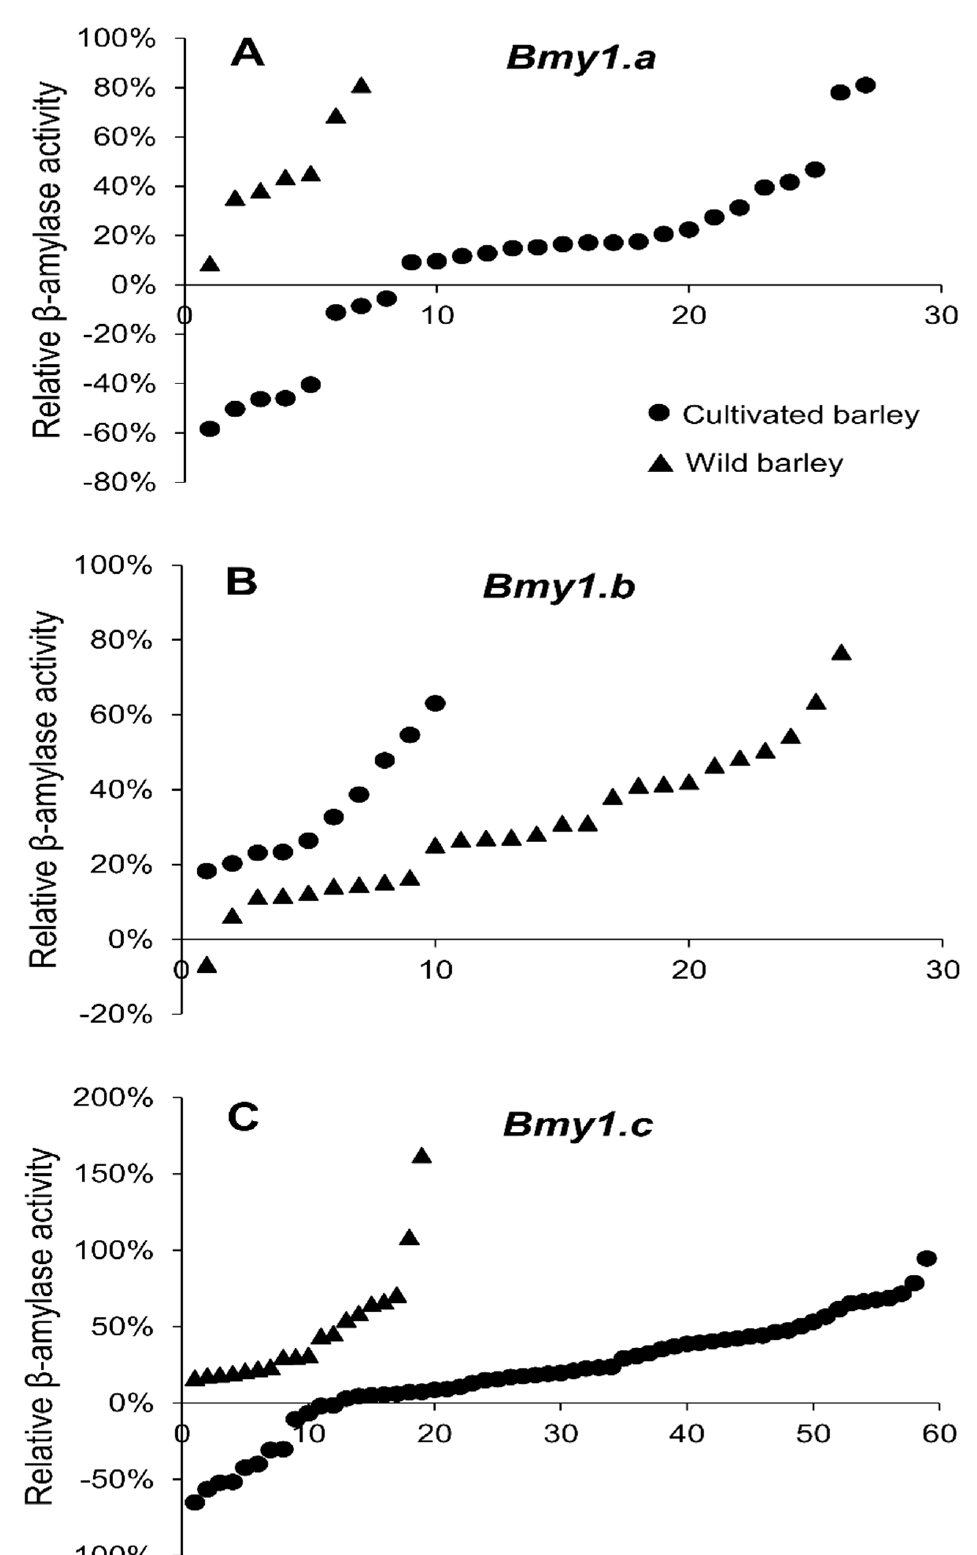
Figure 2. The effect of drought stress on the grain β -amylase activity of 125 barley genotypes compared with control plants. The genotypes were arranged from low to high relative β -amylase activity along the X axis. ( A ) Bmy1.a alleles; ( B ) Bmy1.b alleles; ( C ) Bmy1.c alleles.